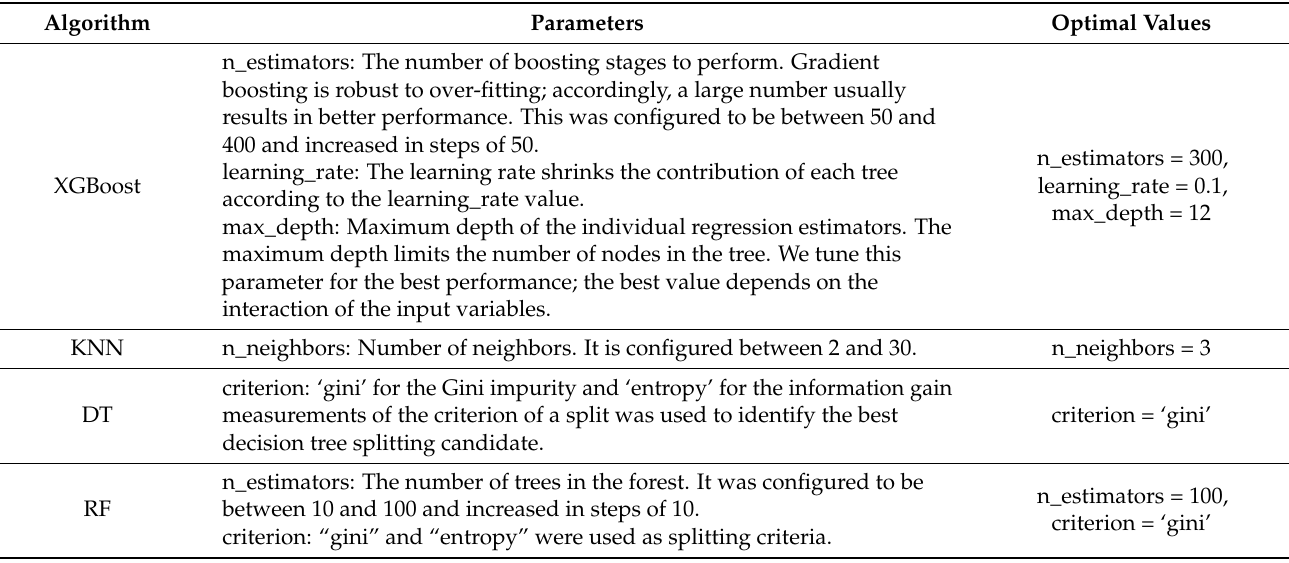
Table 4. Parameter setup for the compared classifiers. Algorithm Parameters Optimal